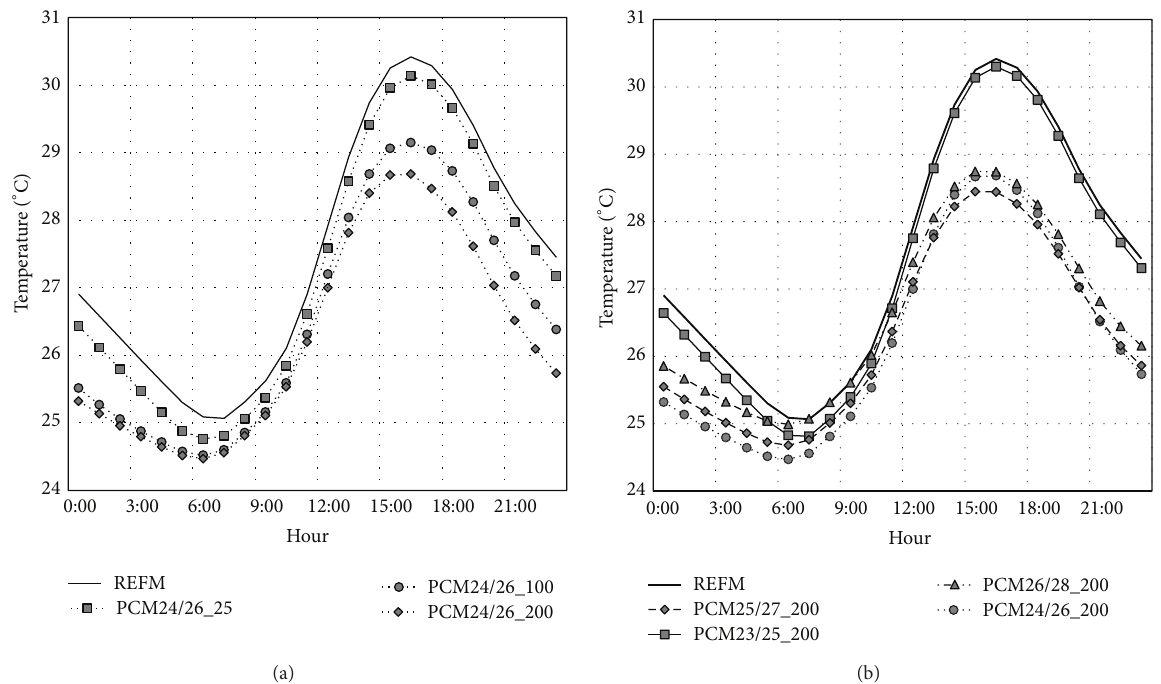
Figure 5: Assessed interior temperatures for the office cell located in Lisbon: (a) enthalpy effect, (b) melting temperature effect.